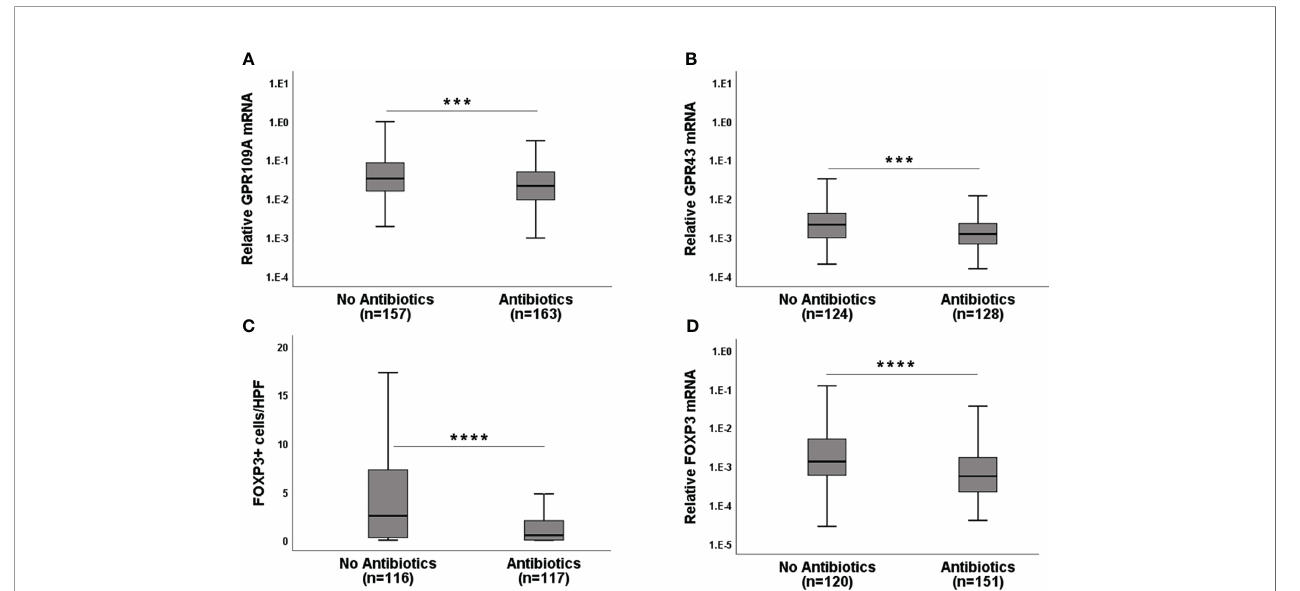
FIGURE 2 | Effect of broad-spectrum antibiotics (Abx) on GPR and FOXP3 expression in the serial biopsies from the gastro-intestinal tract. (A) GPR109A mRNA (B) GPR43 mRNA (C) FOXP3+ cellular in fi ltrates and (D) FOXP3 mRNA expression in the gut biopsies of patients without or with broad-spectrum antibiotic exposure at the time of biopsy retrieval. HPF-high power fi eld. ***p < 0.001, ****p < 0.0001, Mann-Whitney U